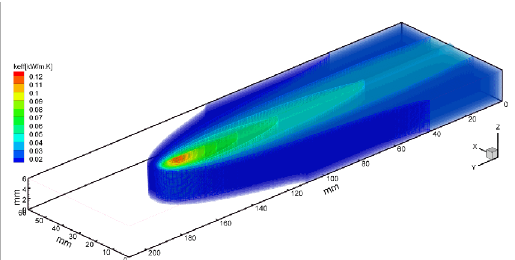
Figure 9. Transient thermal conductivity (k) distributions during the first welding pass (time = 32 s and heat input =1.2 kJ mm -1 )